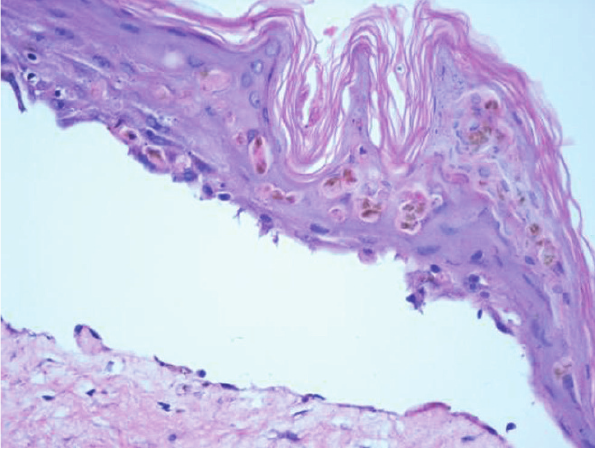
Figure 1 - Skin biopsy stained with hematoxylin–eosin at 6 20 magnification, showing many apoptotic keratinocytes, lympho- cytic exocytosis and spongiosis in addition to the subepidermal cleft.